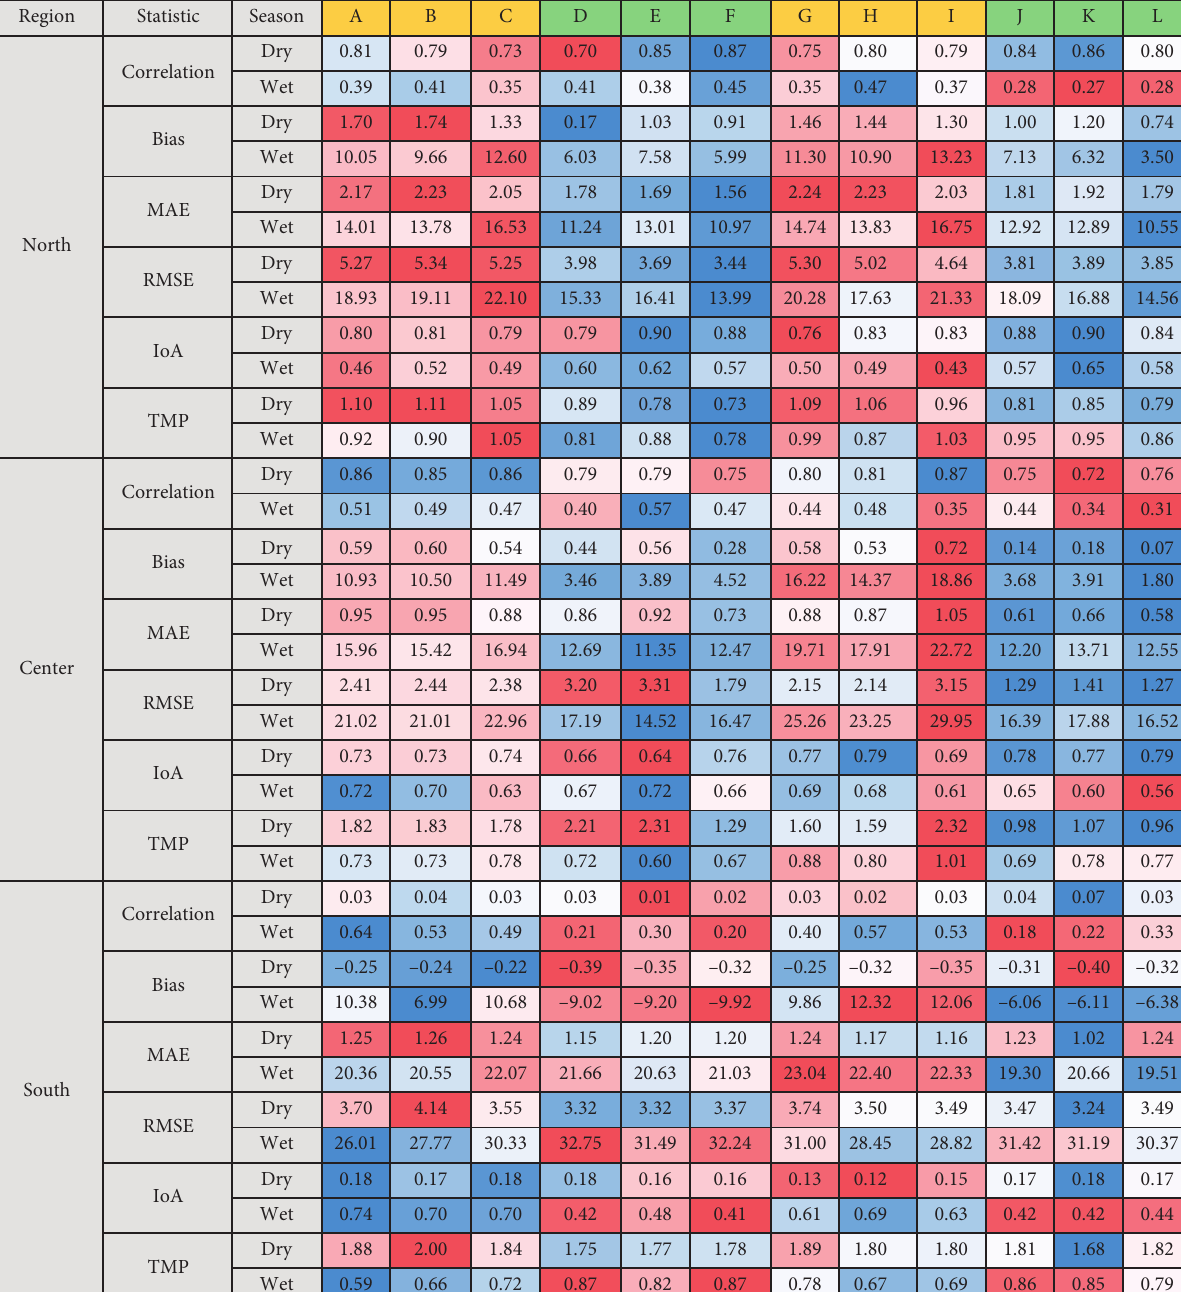
Table 3: Evaluation statistics for region-wise analysis.